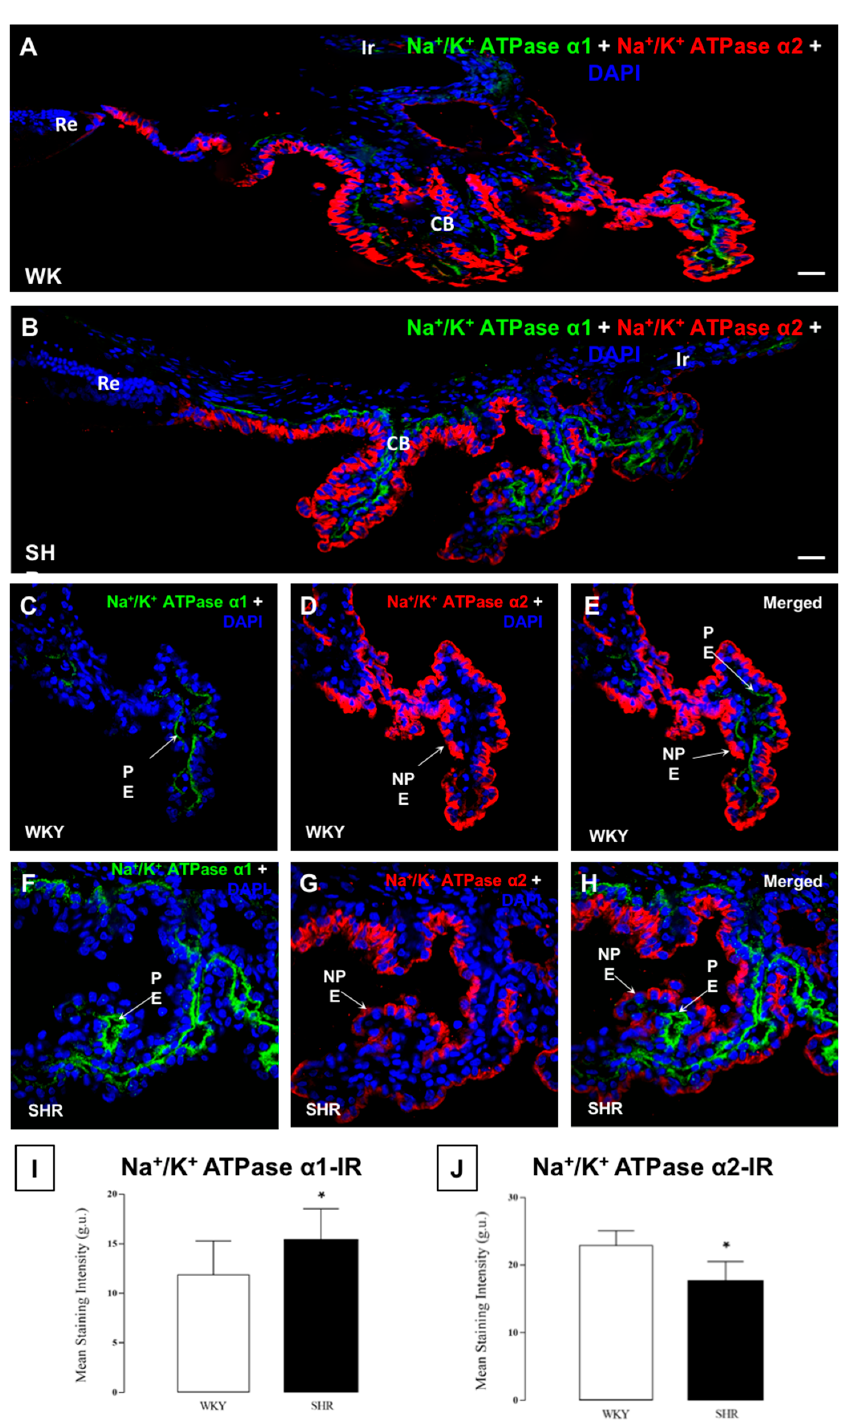
Figure 5. Confocal microscopy images of the expression of Na + /K + ATPase α 1 and α 2 subunits in the ciliary body of WKY ( A ) rats and SHR ( B ) rats. The Na + /K + ATPase α 1 subunit is located in the basal membrane of the PE of the CB and the staining was higher in SHR when compared to WKY rats ( C , F ). A decrease in the expression of α 2 in SHR ( D , G ) rats was observed in the basal membrane of the NPE of the ciliary body. Images ( E , H ) show the localization of both subunits in the CB. At the bottom, values of stain intensities in r.u. for Na + /K + ATPase α 1 ( I ) and Na + /K + ATPase α 1 ( J ) are represented as the means ± SD ( n = ten animals per group) * p < 0.05 WKY vs. SHR rats. Ir: iris; CB: ciliary body; Re: retina; NPE: non-pigmented epithelium; Pe: pigmented epithelium. Scale bars 40 μ m.